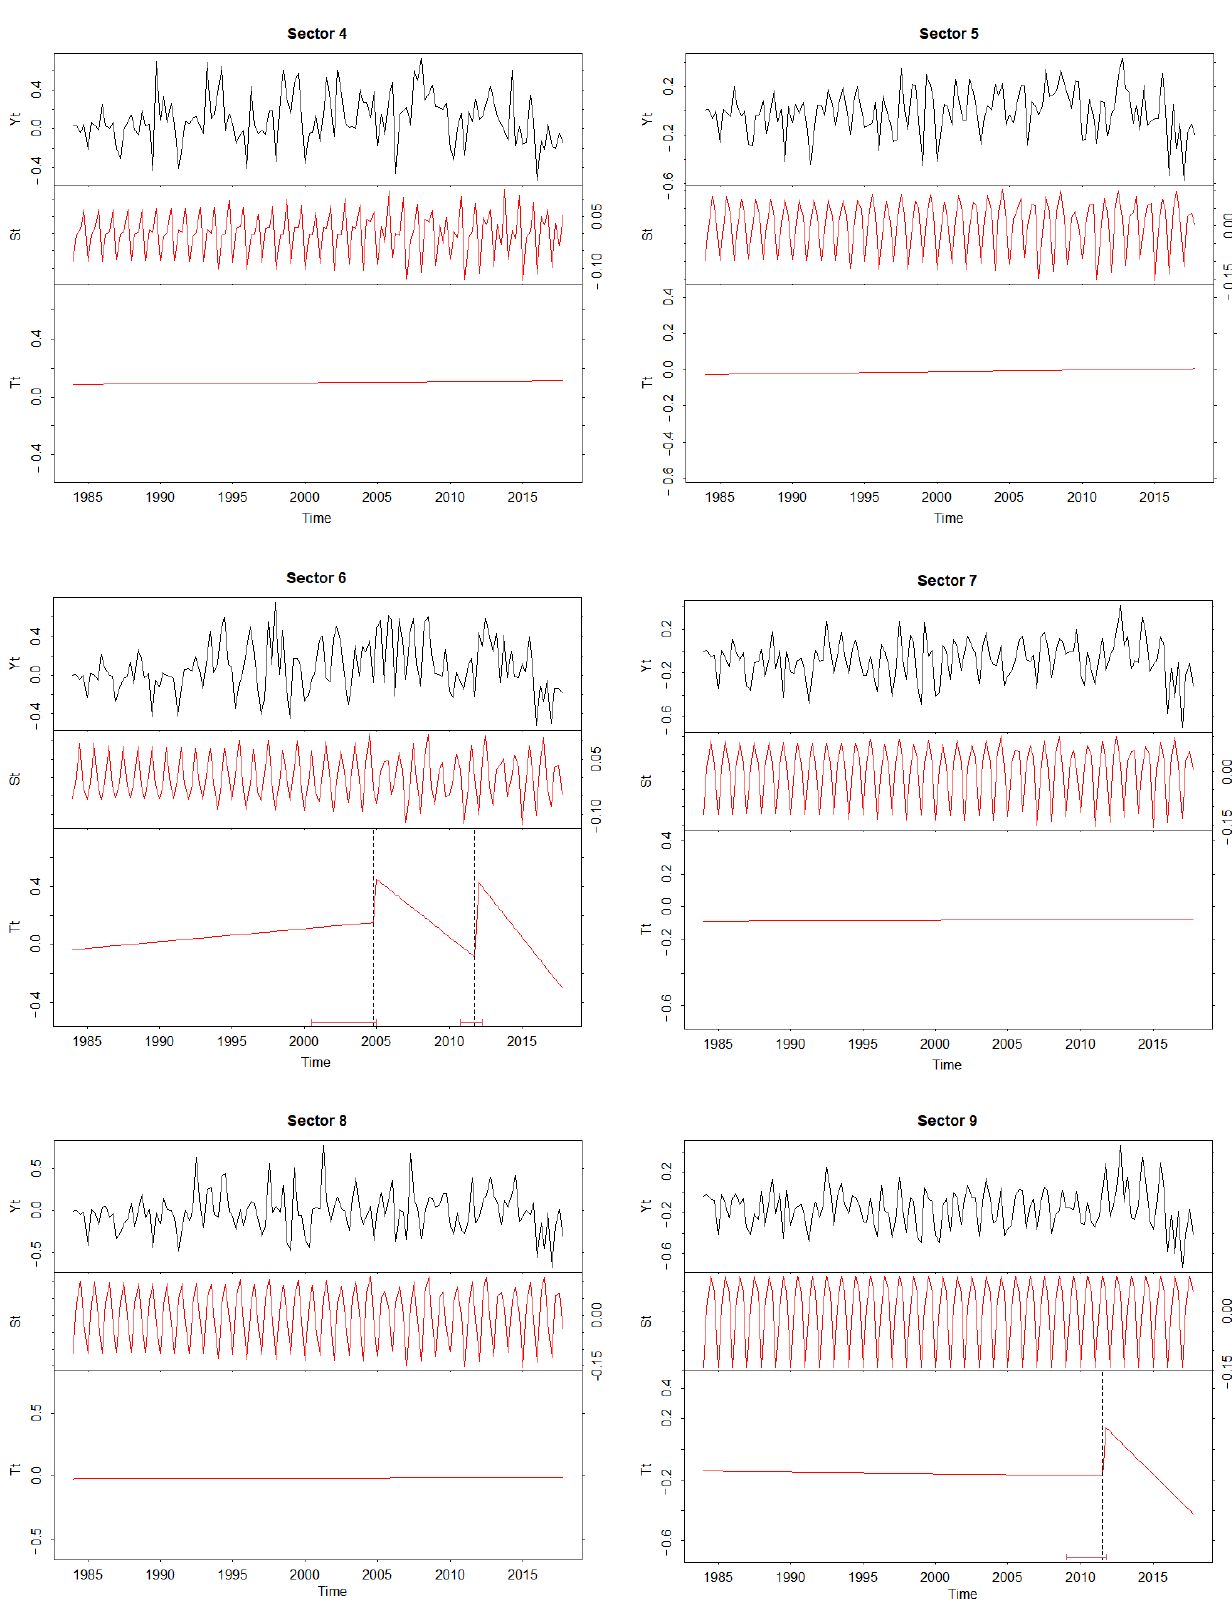
Figure 8. The NDVI time series (Y t ) and its seasonality (S t ) and trend (T t ) components of the segmented areas in the reservoir body compartment (Sectors 4 to 9 from Figure 3c).